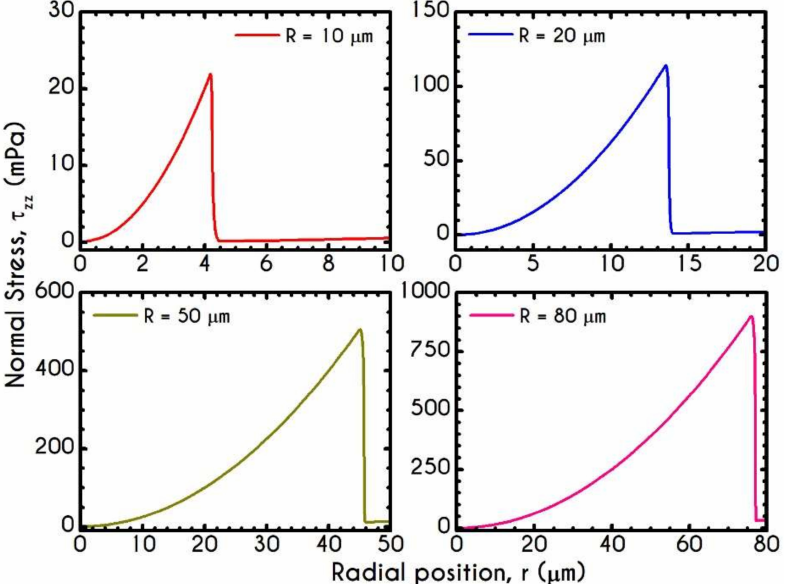
Figure 8. Normal viscoelastic stress τ ve,zz along the radial position r for the tube radius R equal to 10 µ m, 20 µ m, 50 µ m, and 80 µ m for J = 10 4 Pa/m and H c =